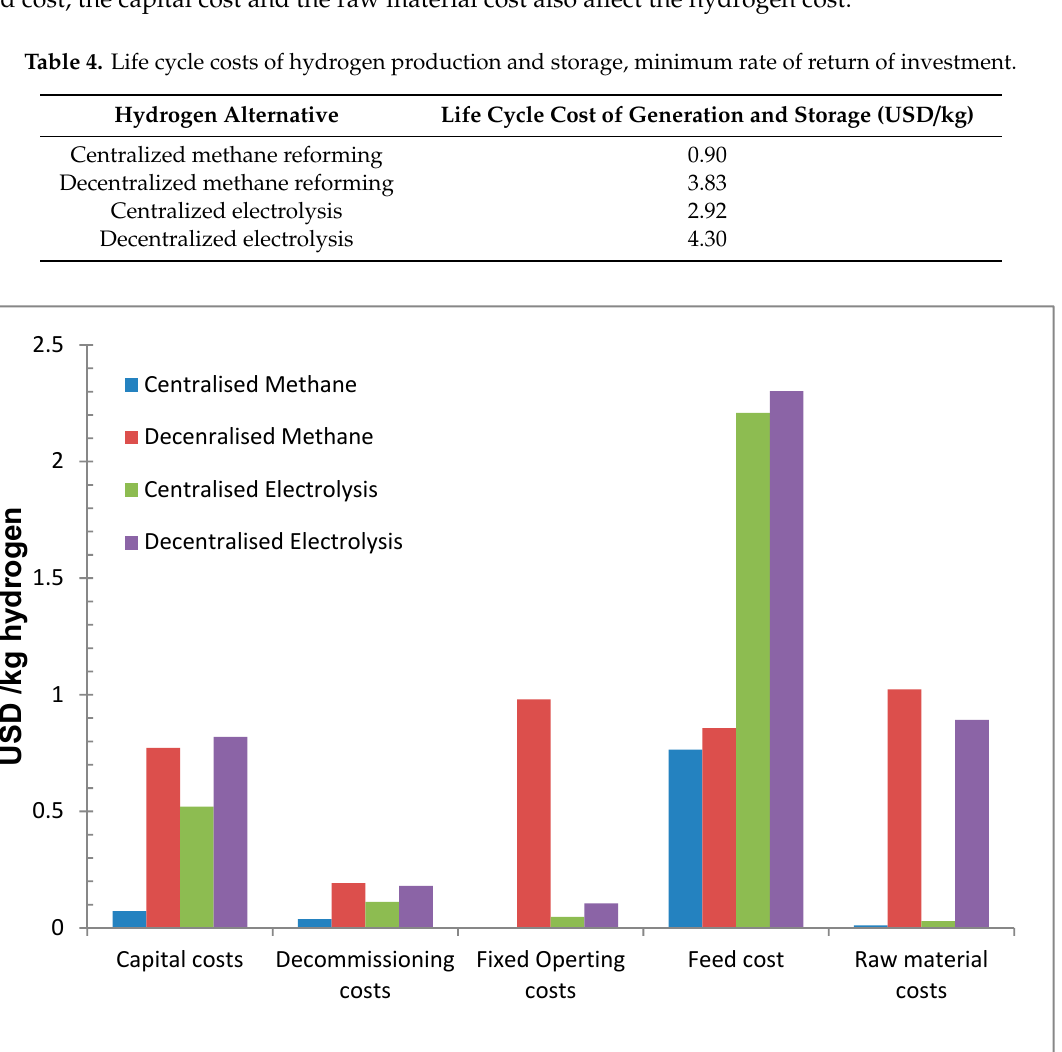
Figure 6. Hydrogen cost contribution for each hydrogen production life cycle.